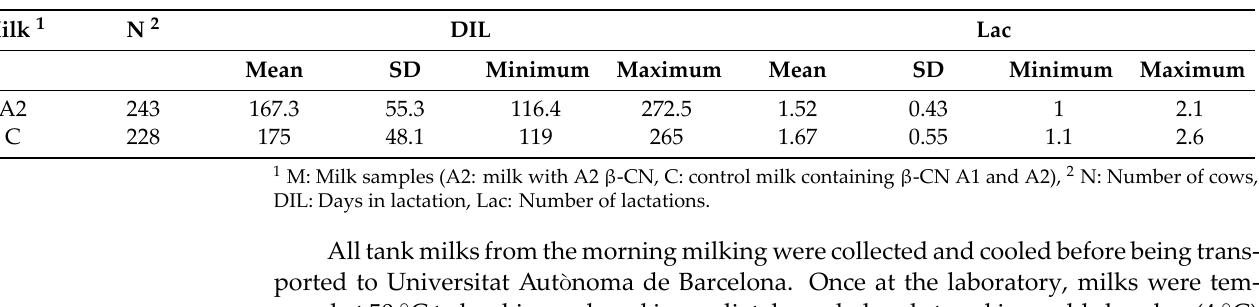
Table 1. Days in lactation and number of lactations of cows used in this